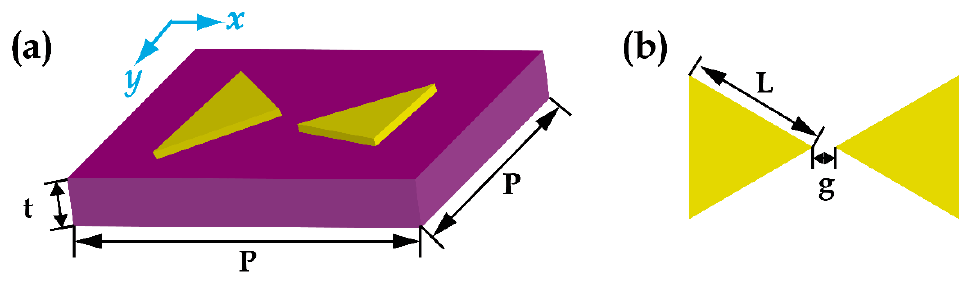
Figure 1. ( a ) and ( b ) Schematics of the DTD structure. Figure 1. ( a , b ) Schematics of the DTD